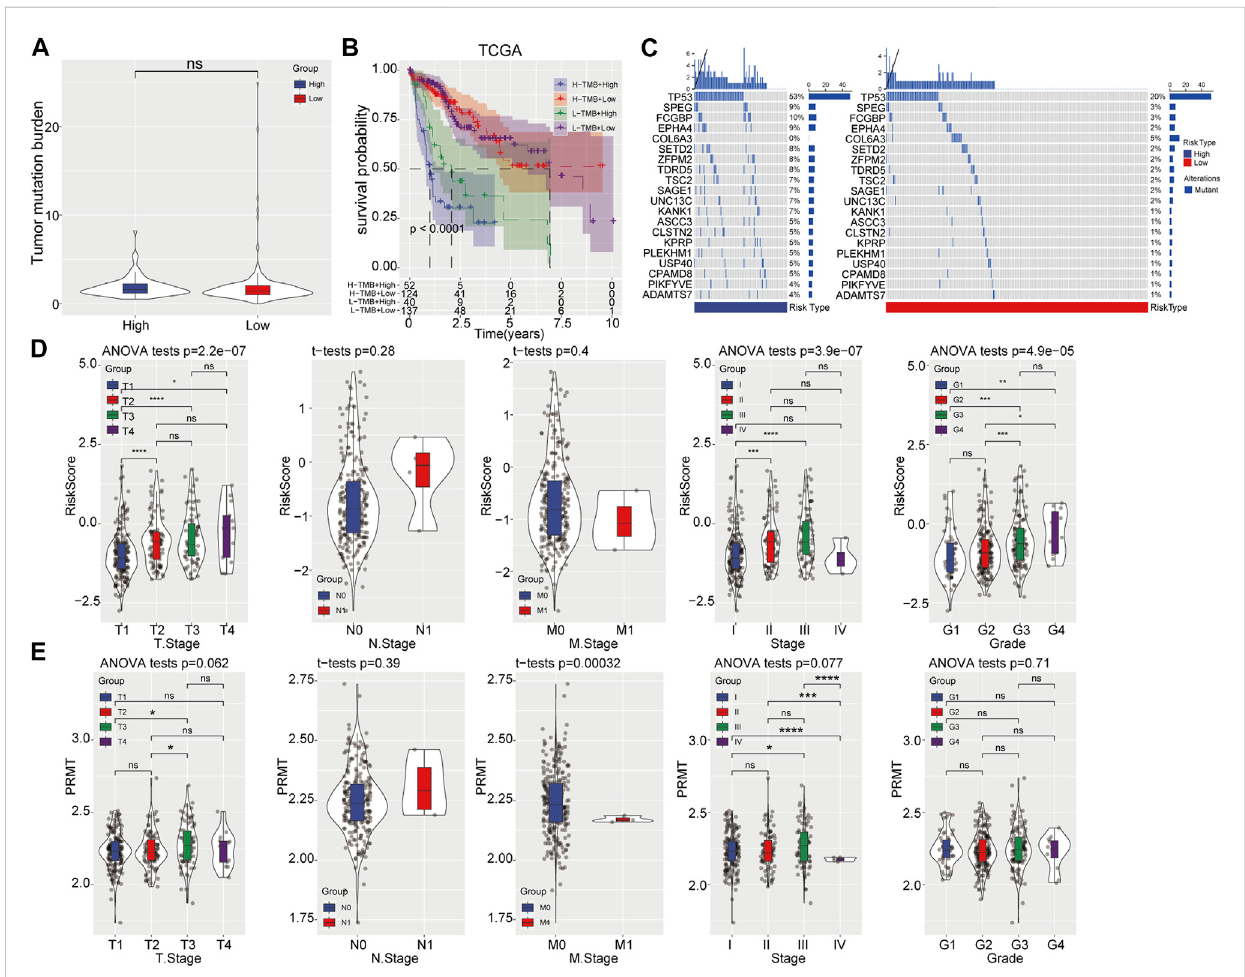
FIGURE 4 Correlationanalysisofprognosticriskmodelwithmutationandclinicopathologicalfeatures. (A) TMBstatusinhigh-andlow-riskcategories. (B) The prognostic risk model combined with TMB to predict the prognosis of HCC. (C) Gene mutation rates in high- and low-risk categories. (D, E) Comparison of risk score and PRMT expression level among patients with different clinicopathological